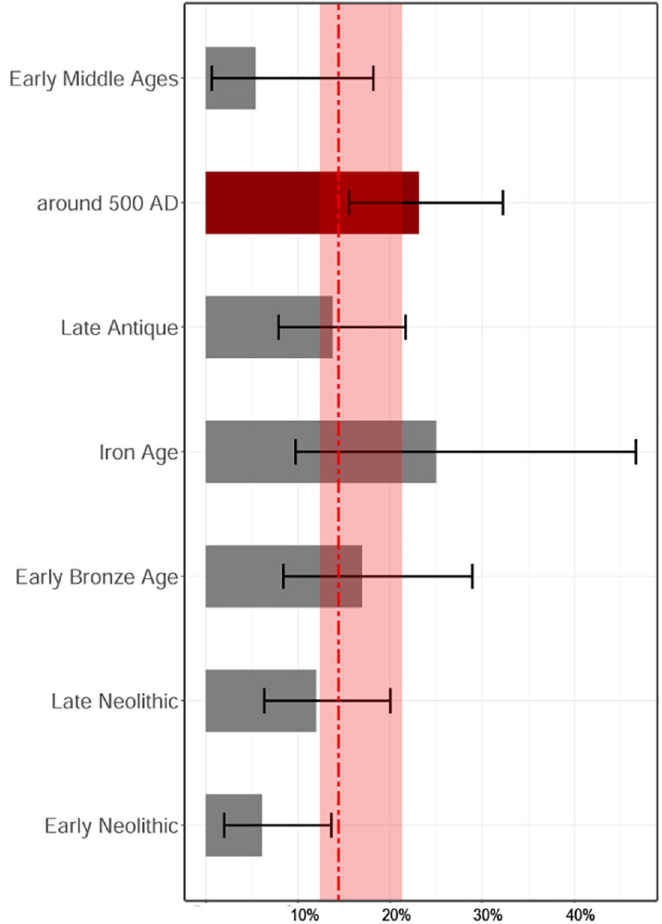
Fig 5. Minimum Frequency of Migrants (MFM) in different periods. Late Neolithic N = 108, Early Neolithic N = 82, Early Bronze Age N = 59, Iron Age N = 24, Late Antique N = 109, around 500 AD N = 108 and Early Middle Ages N = 37. Error bar = confidence interval, red line = mean frequency of immigrants if all periods are considered together, red box = confidence interval for this average.